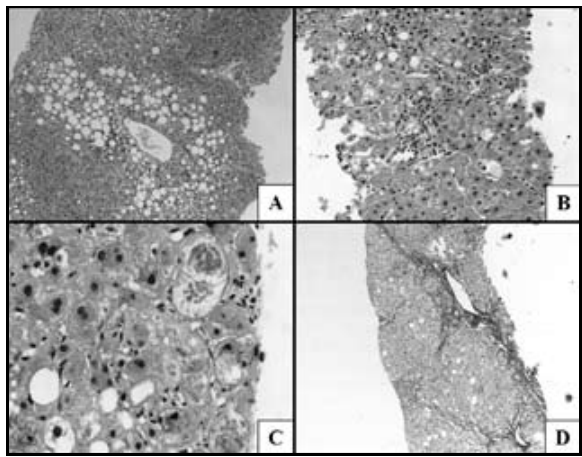
Figure – Histopathological aspects of NAFLD. A: macrovesicular steatosis around the centrolobular vein. There is a small focus of lobular activity under the vein (HE, 100x); B: moderate NASH with scattered ballooned and steatotic cells (HE, 20“0x); C: Mallory bodies in an extremely ballooned cell (HE, 400x); D: fibrosis stage 3 (Gomori’s thricrome, 50x)